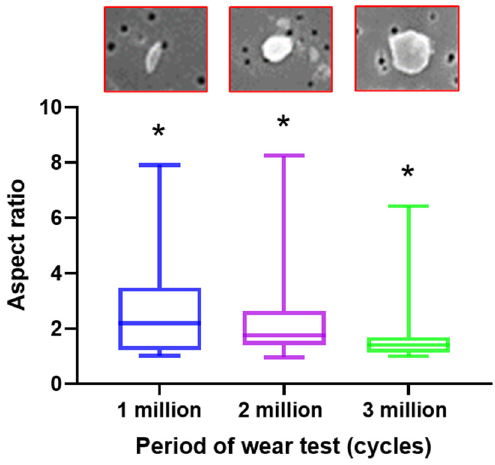
Figure 6. Distribution of aspect ratio after every one million cycles. (*: p < 0.05)